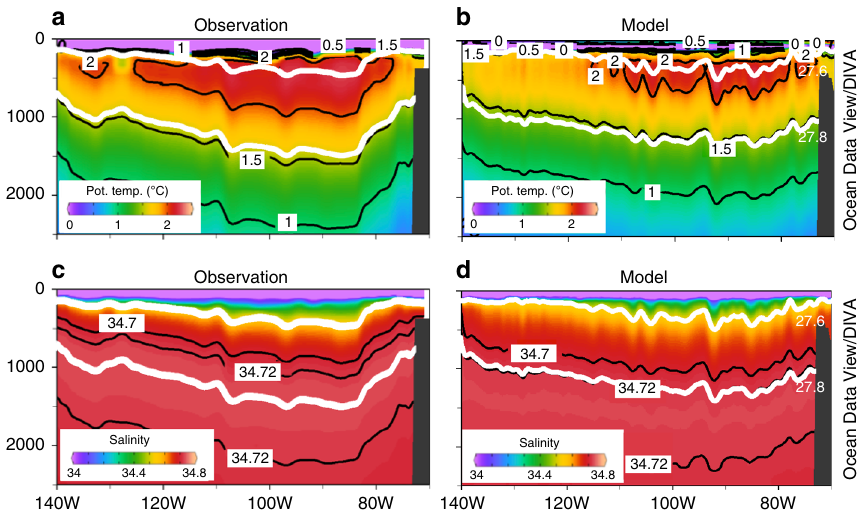
Fig. 2 Observed and simulated sections of potential temperature and salinity in Jan 2011 along World Ocean Circulation Experiment (WOCE) S04P section (67°S). For all panels, potential temperature or salinity contours are shown with black lines with potential density contours of 27.60 and